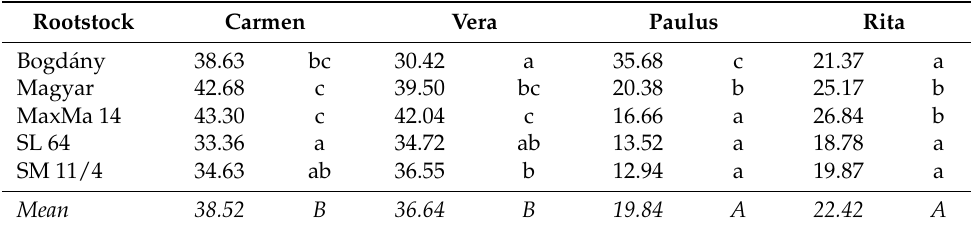
Table 3. Cumulative yield of trees 2017–2022